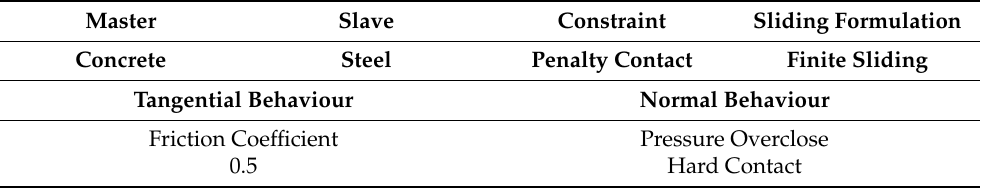
Table 8. Interaction properties.